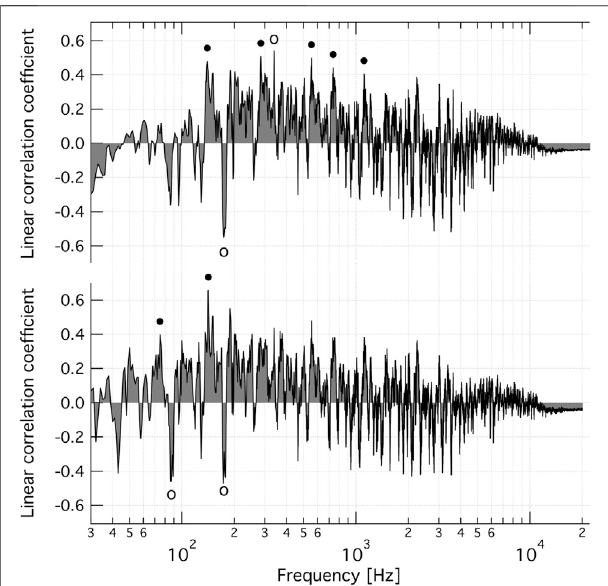
FIGURE4| Frequencydependenceofthecoef fi cientoflinearcorrelation between band intensity of the FFT spectra of normalised music clips and changes inspeci fi c V-ATPase activity caused byoscillating AC fi eld ofmusical content,afterbest fi ttinglinearscaling.Top:Circlesindicateharmonically related peaks at 146 ± 12, 285.8 ± 8.0, 559 ± 21, 743 ± 31, 1,127 ± 43 Hz (solid circles) and 175.4 ± 4.9, 338.9 ± 4.8 Hz (open circles). The bandwidth was 1.4 Hz. Bottom: Base frequency plus the fi rst 3 overtones. Circles indicate the harmonically related peaks at 73.4 ± 5.2 and 143 ± 15 Hz (solid circles) and 87.1 ± 2.3 and 175.0 ± 4.2 Hz (open circles). The bandwidth was 0.22 Hz. The ± frequency intervals indicate the line-width of a Gaussian function fi tted to the respective